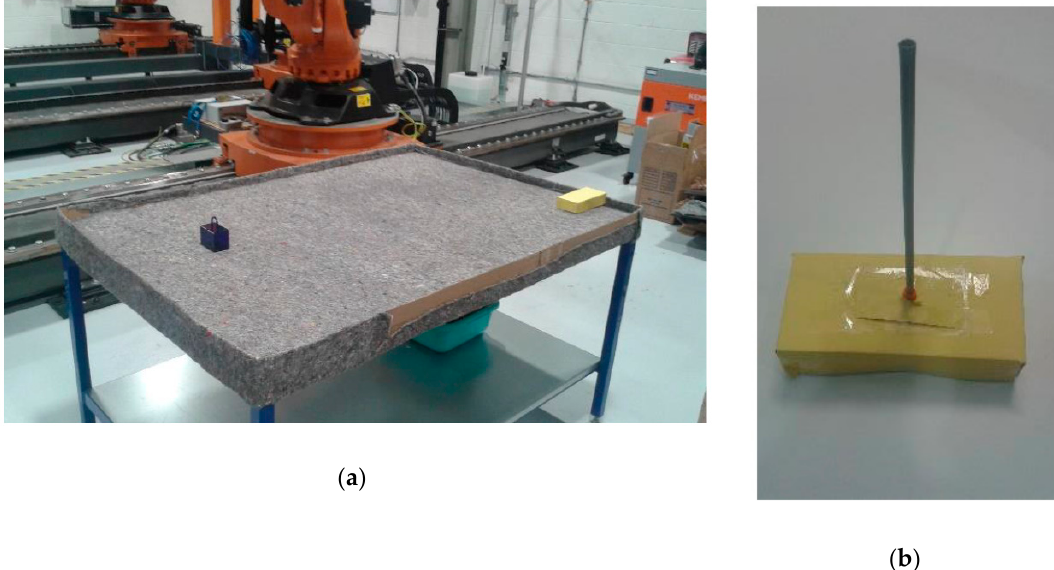
Figure 12. Workspace table implemented for the robot: ( a ) General overview including robot base, covered table, pick-and-place box and moving obstacle; ( b ) Moving obstacle covered in yellow color with a 30 cm ‘spike’ on its top.